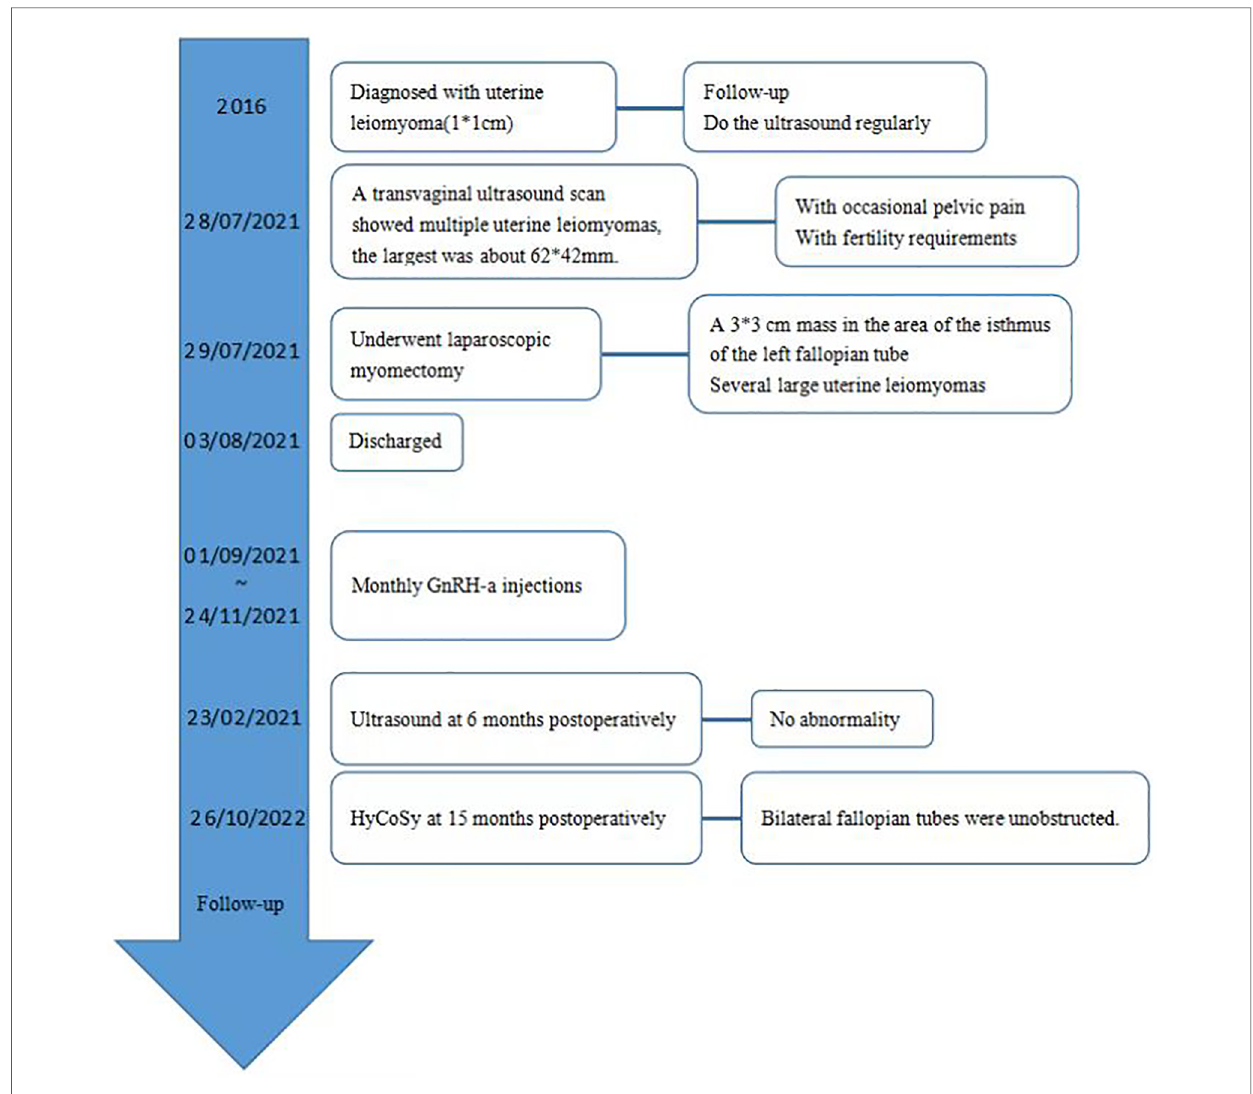
FIGURE 3 Hysterosalpingo-contrast-sonography (HyCoSy) at 15 months postoperatively showed bilateral fallopian tubes were